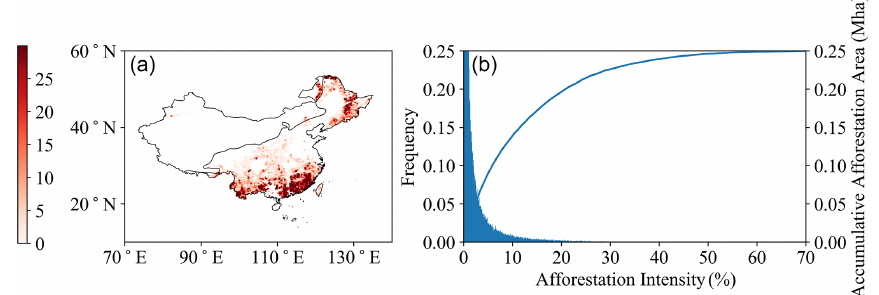
Figure 3. (a) Spatial distribution of afforestation intensity ( F aff ) in China during 2000–2012. The solid black line crossing China is the 400mm annual precipitation isoline. (b) Frequency distribution of F aff and cumulative afforestation area with the increase in F aff . The dashed red line represents the cumulative afforestation area corresponding to F aff =